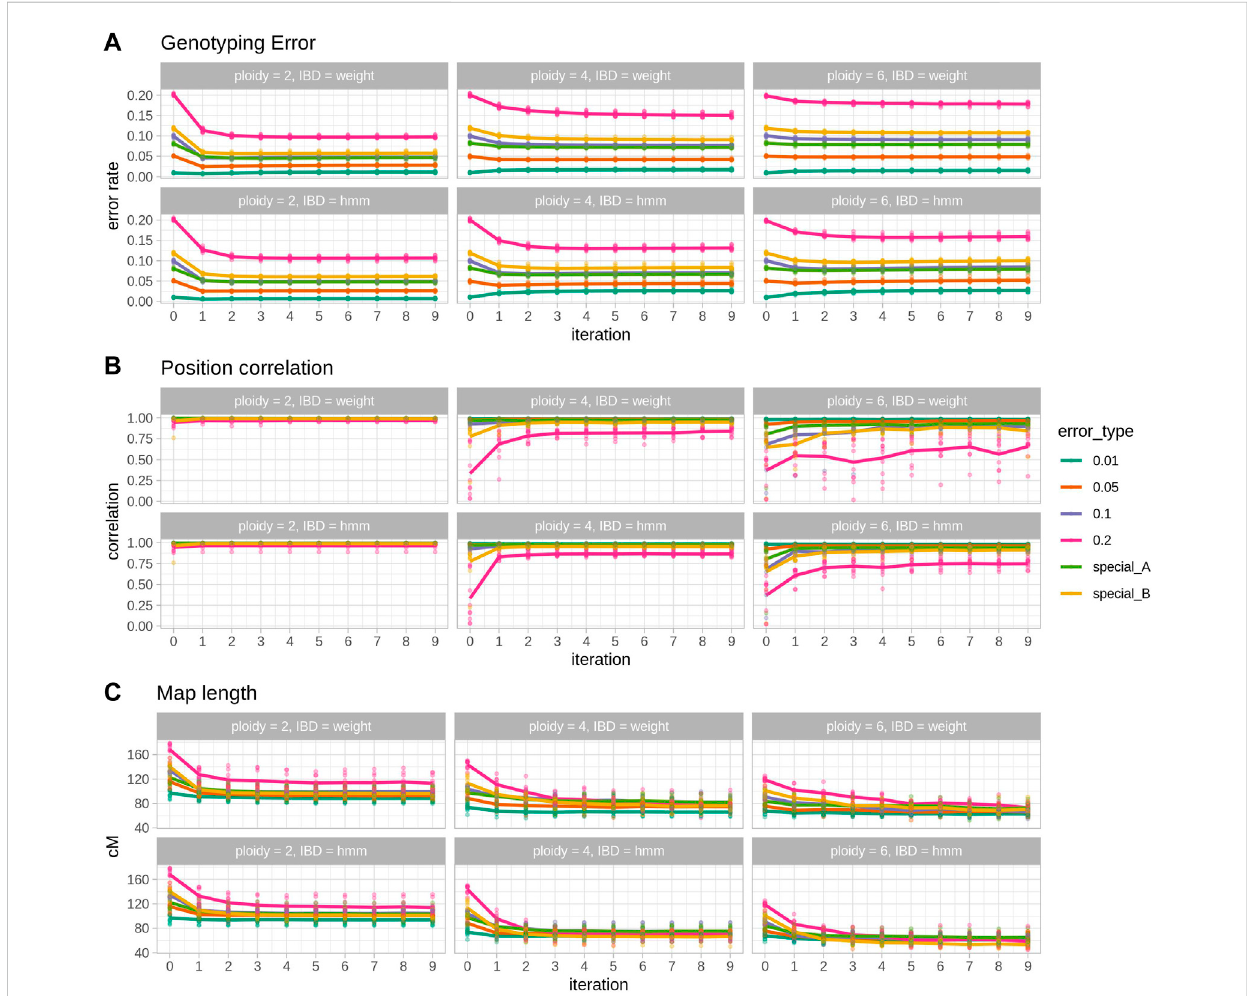
FIGURE 1 Results of 10 simulated populations across error rates and ploidies. Within each section, each column represents a ploidy and panel the top row shows the results for the IBD estimation with the weighted average procedure (IBD = weight) and the bottom row for the IBD estimation with the HMM (IBD=hmm). (A) Genotypingerror,therateofgenotypesthataredifferentfromthetruegenotypes. (B) Positioncorrelation,thecorrelationbetweentrue genetic positions and estimated positions in a genetic map. (C) Map length, the size in cM of the estimated maps. In each plot, points represent individual observations and lines are the average. Each colour represents one simulated error type, with special A being heterogeneous rate across individuals and special B being heterogeneous rate along the